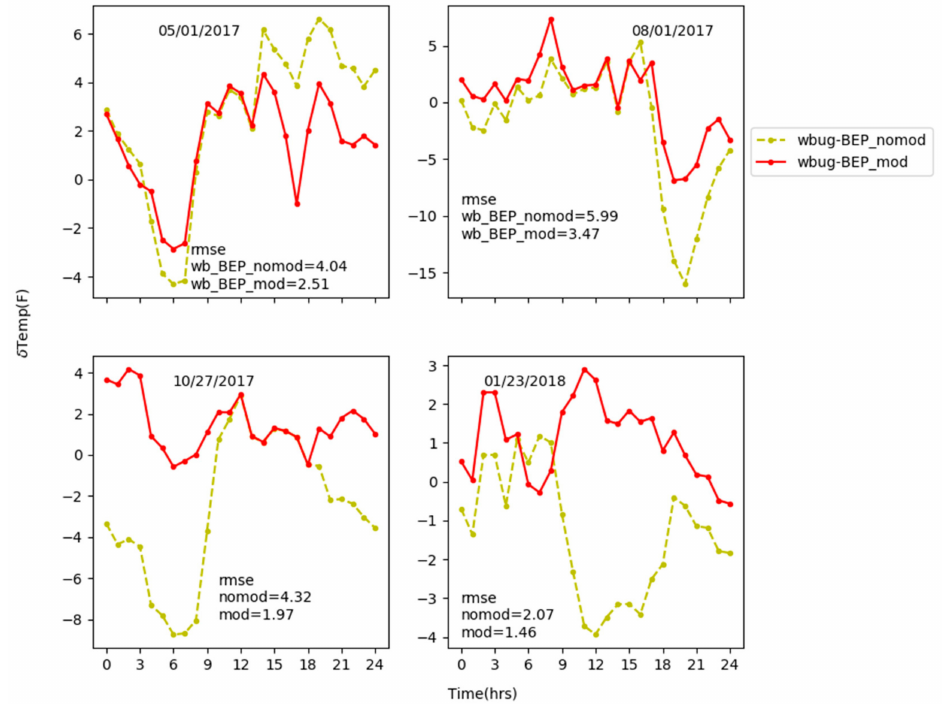
Figure 6. RMS error calculation between the modeled surface air temperature and the observations of the College Park airport